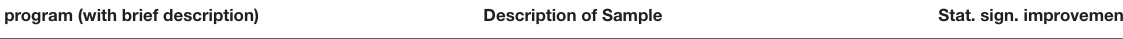
TABLE 1 | IES what works clearinghouse (WWC)